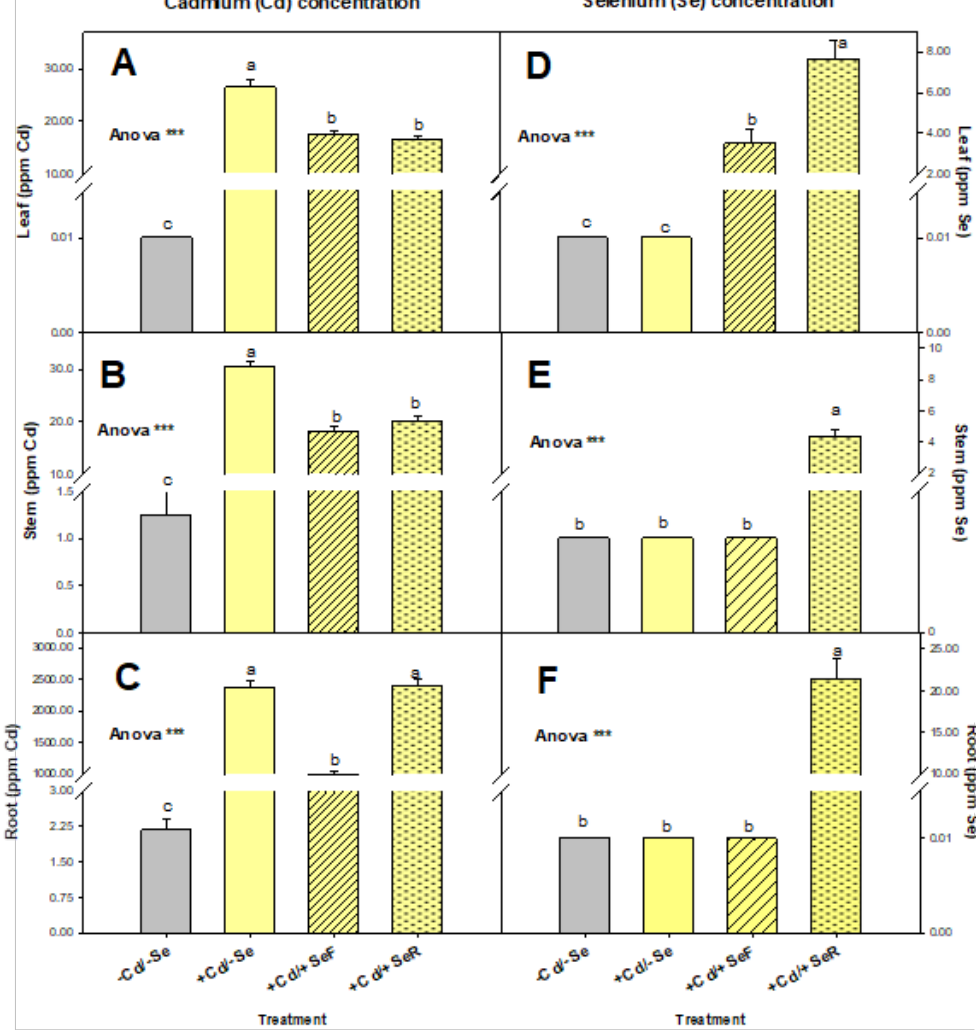
Figure 2. Concentration of cadmium (Cd; ( A – C )) and selenium (Se; ( D – F )) in the different tissues of the plant (leaf, stem, and root) of pepper plants under four treatments of cadmium and sele- For the parameters of gas exchange, at the end of the experiment, it was observed nium ( − Cd/ − Se, +Cd/ − Se; +Cd/+SeF and +Cd/+SeR). In the ANOVA, *** indicates significant that the +Cd/-Se and +Cd/+SeF treatments had a decreased net assimilation of CO 2 (ACO 2 ) differences for p < 0.05. The different lowercase letters indicate significant differences between the and stomatal conductance (g s ) (Figure 3A,B). This decrease was significant and similar for treatments for p < 0.001 established by Tukey’s multiple range test. The vertical bar indicates the both treatments, with the ACO 2 decreasing by 78% and gs by 65%, with respect to the standard error of the control plants (-Cd/-Se). These two parameters, however, were not affected by the +Cd/+SeR treatment. The CO 2 substomatic (Figure 3C) tended to increase in all the plants subjected to excess Cd relative to the control treatment, although this increase was not significant in the treatments with Se as compared to the control plants. The water use efficiency (WUE; Figure 3D) decreased significantly in the second week for the +Cd/-Se and +Cd/+SeF treatments with respect to the control plants. The quantum efficiency of PSII (Figure 3E) did not show significant differences between the different treatments.